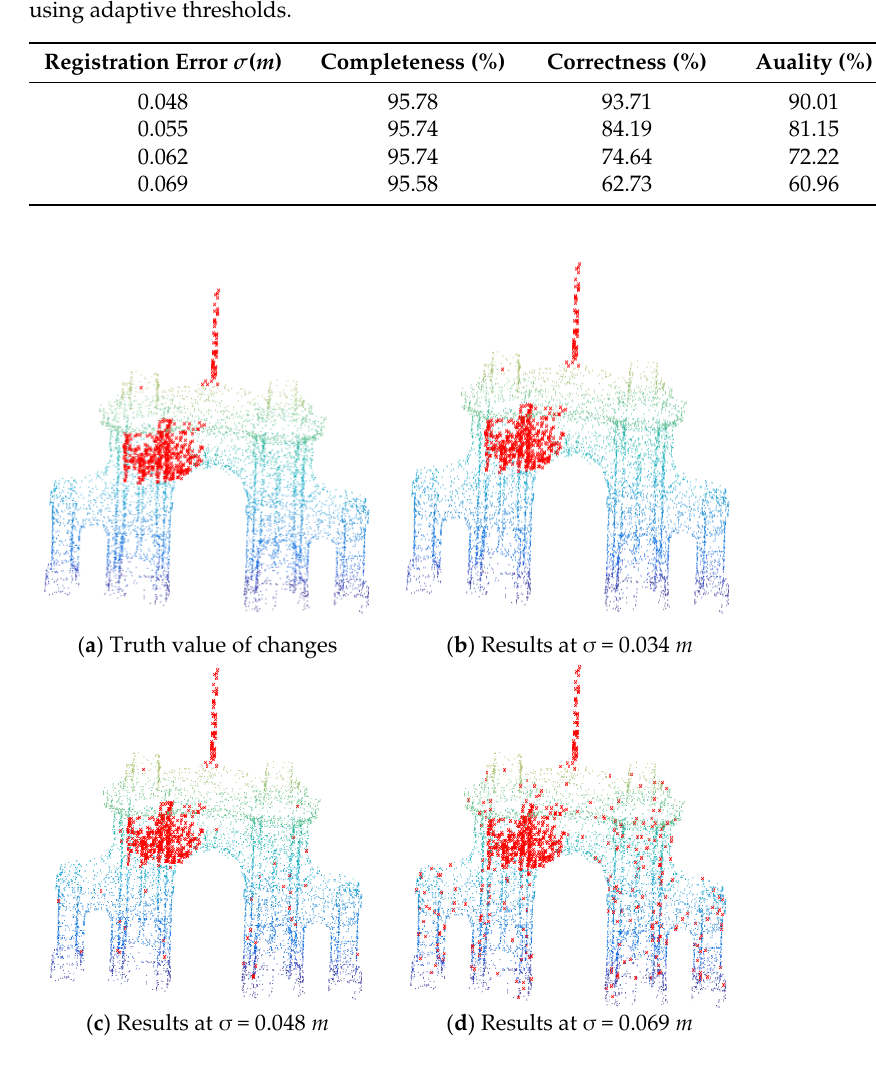
Figure 5. Qualitative comparison of 3D change detection at different misregistration of two point clouds (red points represent the change regions): ( a ) ground-truth of the change points and ( b – d ) results of change detection at the registra- tion errors σ = 0.034 m, 0.048 m, and 0.069 m, respectively.